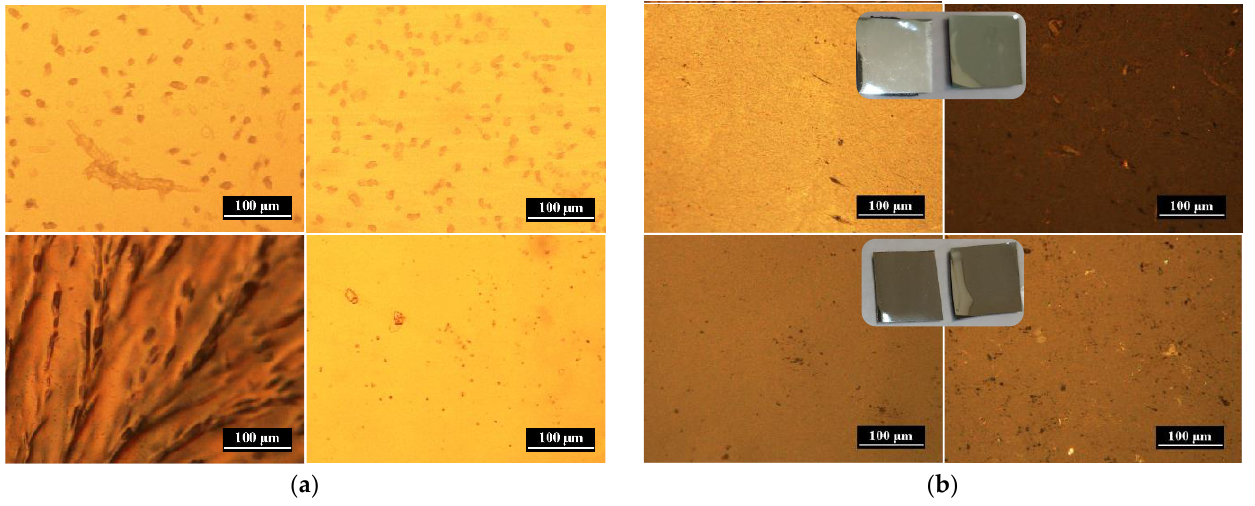
Figure 2. Optical microscopy (OM) images of polymer composite films: ( a ) F1 ( top ) and F1Ag ( bottom ), ( b ) F2Ag ( top ) and F3Ag ( bottom ). Surfaces of the films were studied under OM from the top ( left ) and from the bottom ( right ).